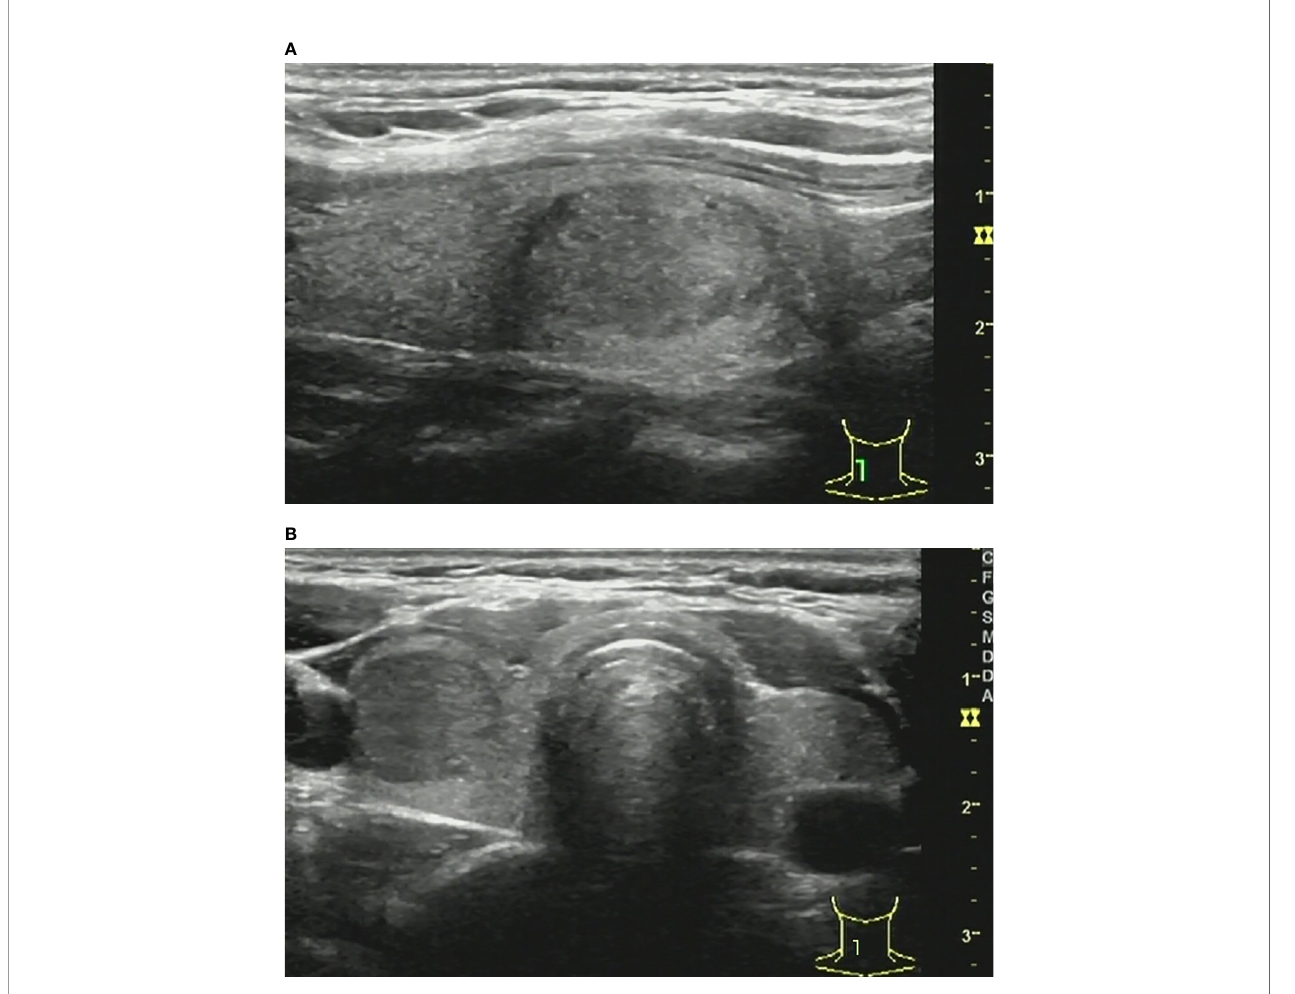
FIGURE 4 | 33-year-old woman with thyroid hyperplasia. Sonographies of longitudinal scanning (A) and axial scanning (B) show the nodule locates at the right lobe of the thyroid, characterized by 19.46mm×11.97mm×9.74mm in size, solid composition, elliptical shape, A<T orientation, almost isoechoic, well-de fi ned margin, and absence of posterior acoustic effect. C-TIRADS 4A, K-TIRADS 3, ACR-TIRADS 3. Histopathology con fi rmed it is a thyroid